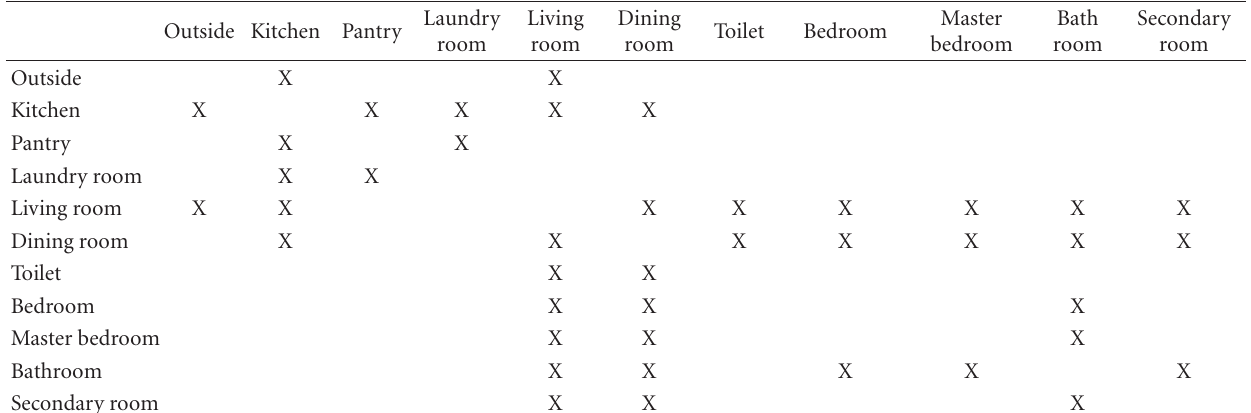
Table 1: Possible connections between rooms.